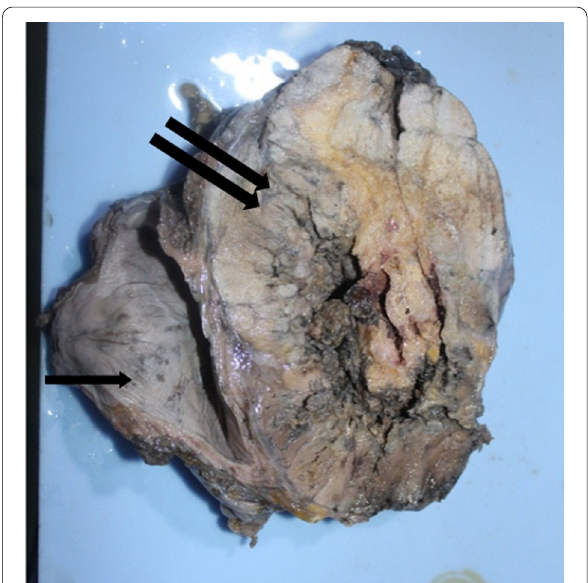
Fig. 1 Anterior view of the bladder tumour. The bladder is seen opened on the left (single arrow) while the mass is seen attached to the posterior wall (double arrows)